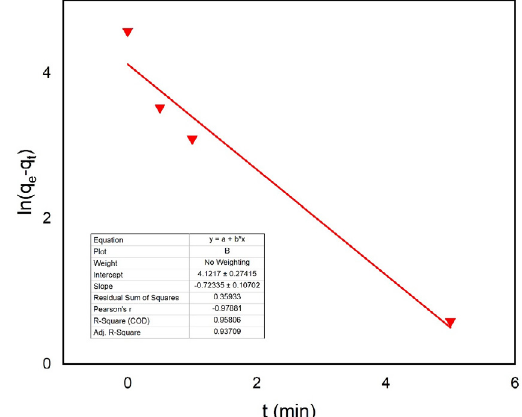
Fig. 7. Effect of contact time on Pb(II) adsorption. Fig. 8. Adsorption kinetics; pseudo-first-order model.